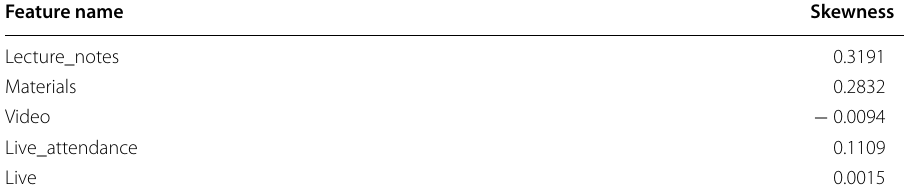
Table 2 New skewness values for the